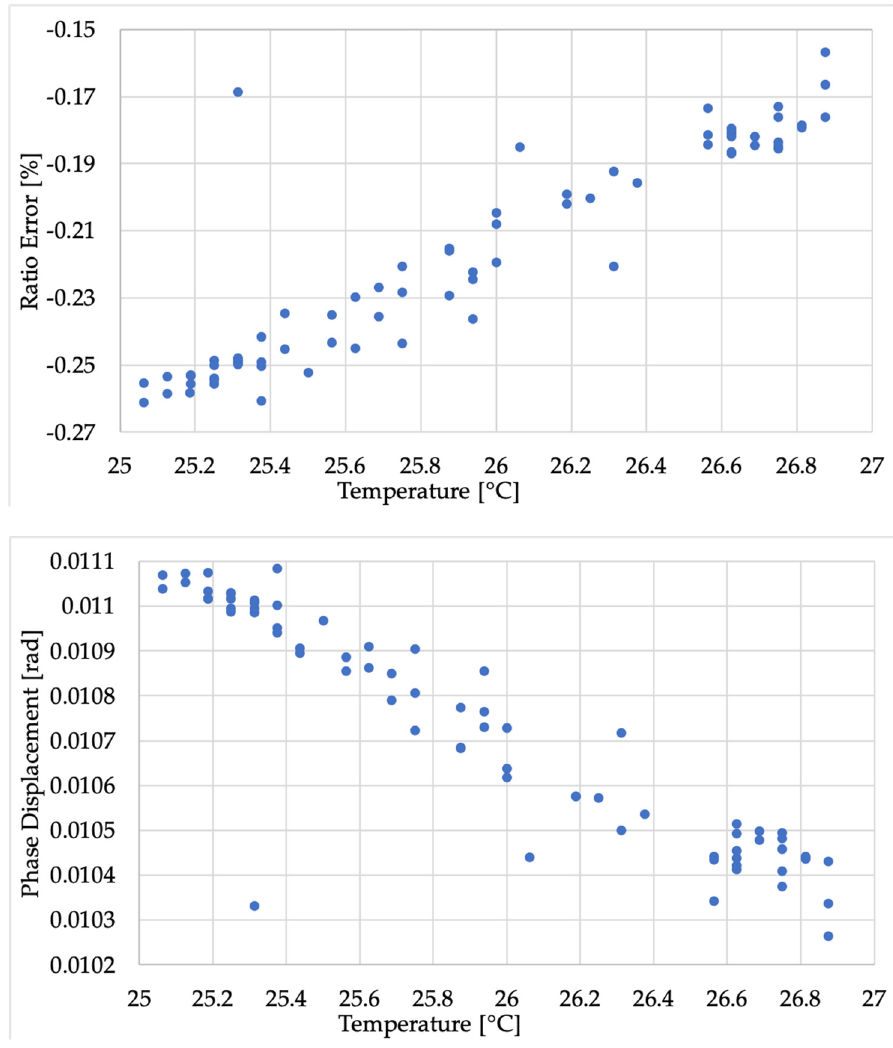
Figure 6. Correlation graphs between ε and T ( top ) and Δ φ and T ( bottom ) for VT C.